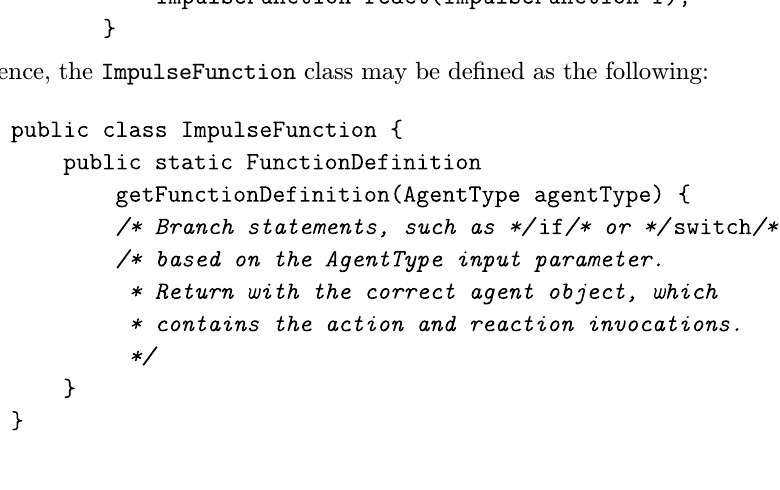
concrete implementation of the factory design pattern 13 . The emmitFunction method of the NonLivingAgentMechanism object holds a very similar purpose as the reflect() method (cid:1)(cid:1)(cid:1) it reacts to the input function, and returns a new function object, which possess the change invoked in the non-living agent